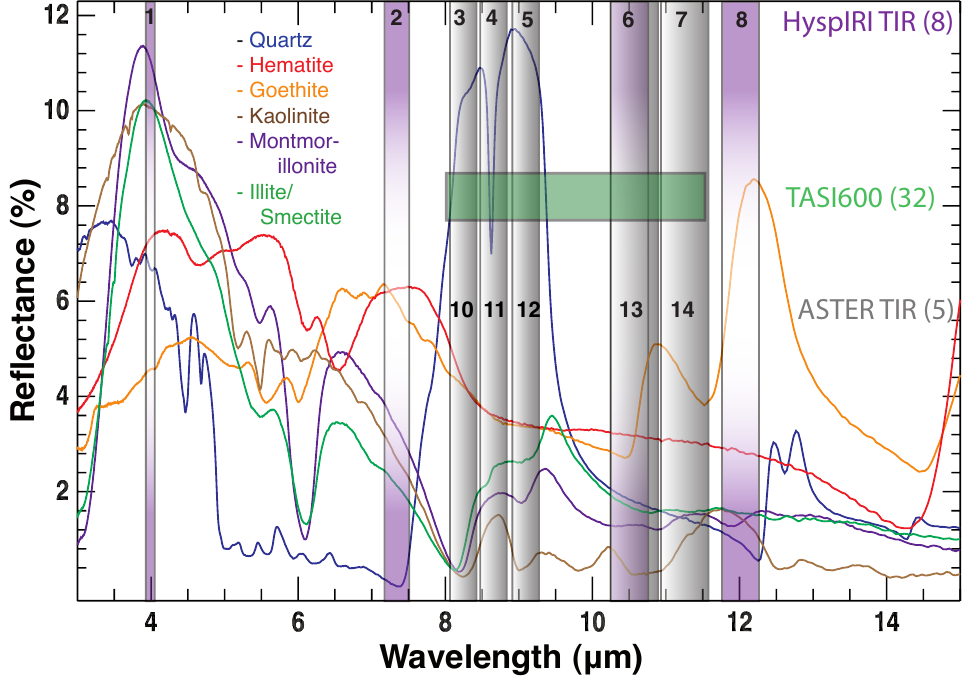
Figure 4. MWIR and TIR spectral reflectance signatures (DHR-measurements) of typical arid and semi-arid soil minerals, from the ASTER spectral library [31]. Grey and grey-pink bars indicate the spectral characteristics of the TIR bands from the satellites ASTER and HyspIRI (TIR module on a planned NASA